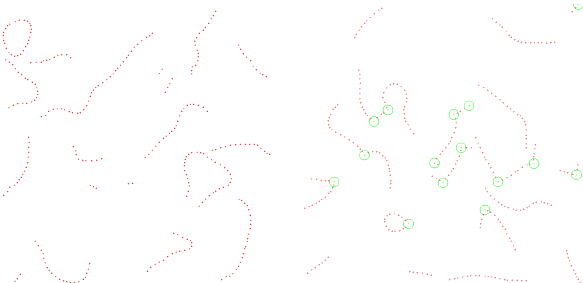
Figure 6. Point distribution simulated with an alternative geometric prior. Our shape prior can be completed by an additional term that favors smooth (left) and piecewise-smooth (right) angles between successive Delaunay edges. Points are then distributed regularly along curves. This complementary prior can be used for extracting free-form object